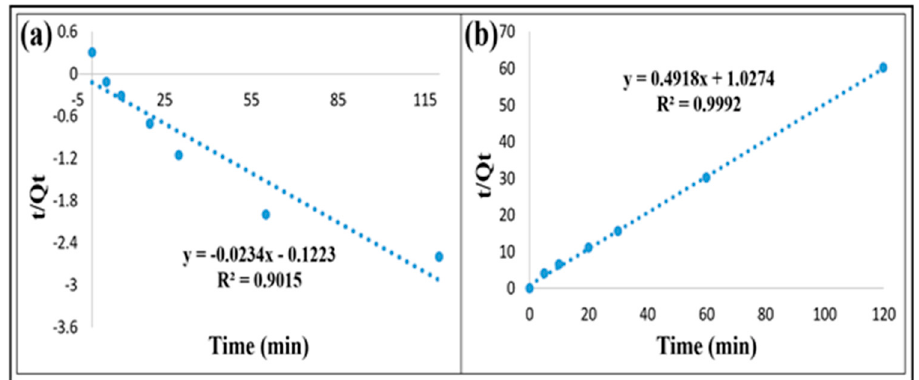
Figure 7. Pseudo-first-order and pseudo-second-order kinetics for adsorption of